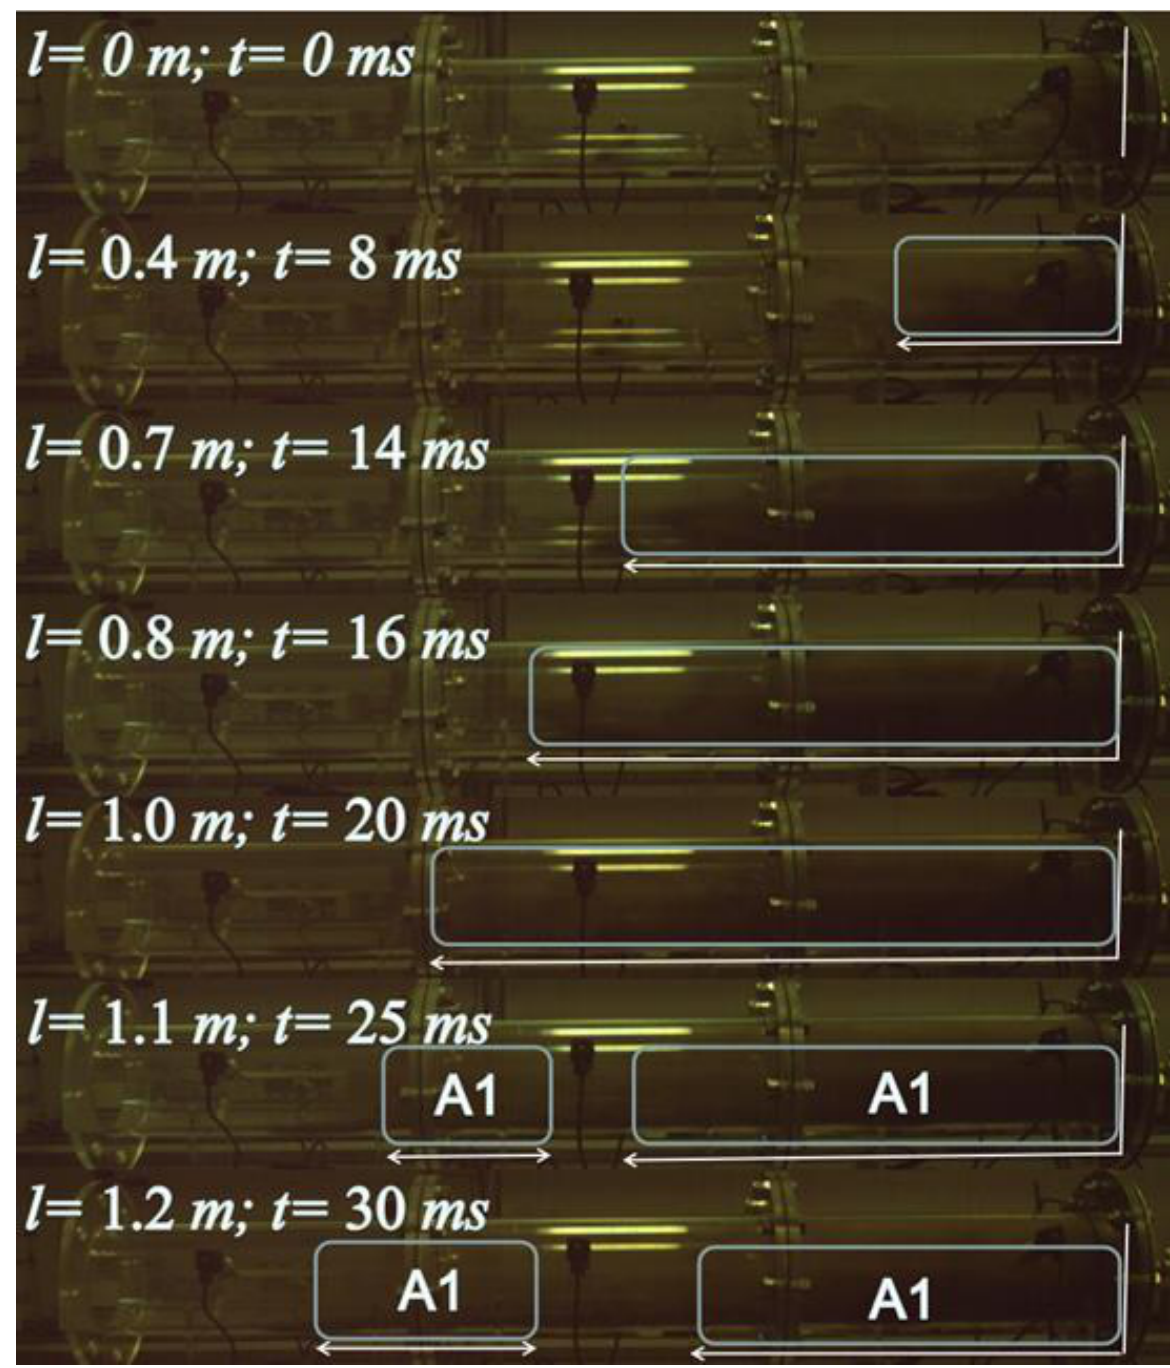
Figure 8. The oil shale powder spraying process. During the experiment, the oil shale was mixed with MSA, MSA–NaHCO 3 , and NaHCO 3 , and these mixtures were tested according to the material ratio and ex- perimental parameters shown in Table 5. The experiment started with the smallest dose of the inhibitor and increased thereafter at regular intervals. Each experiment was repeated three times. The result of the group of flame propagation characterization experiments with the longest flame was further